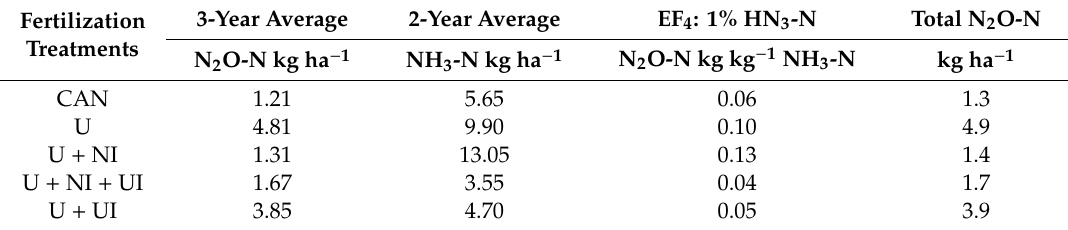
Table 7. Combined e ff ect of N 2 O-N and NH 3 -N losses on N 2 O emissions for urea (U) with nitrification inhibitors (NIs) and urease inhibitors (UIs) during the growth season of winter wheat estimated according to IPCC emission factor EF 4